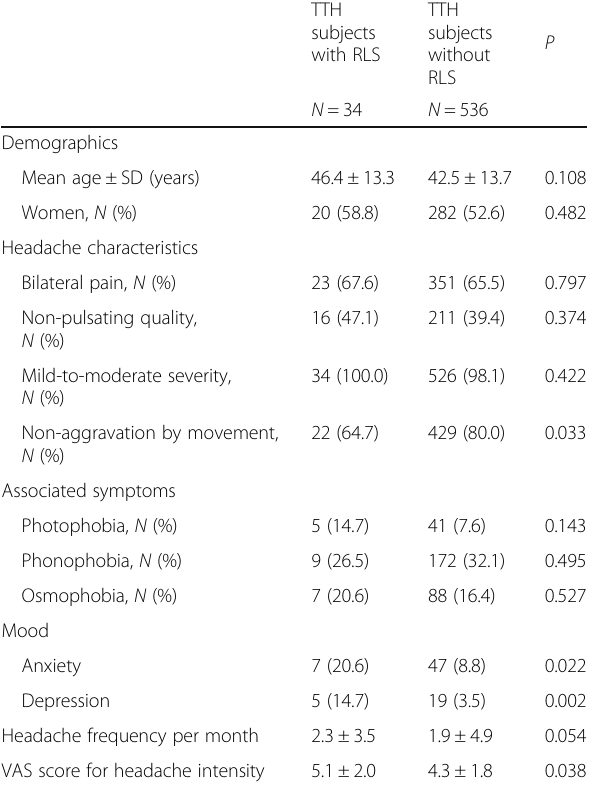
Table 2 Demographics, headache characteristics, and associated symptoms in subjects with TTH according to the presence of RLS